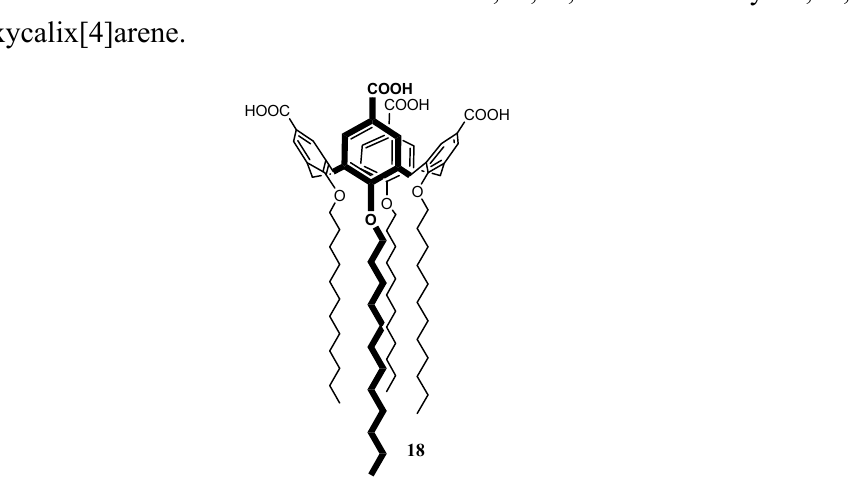
Figure 30. Chemical formula of 5,11,17,23-tetracarboxy-25,26,27,28- tetradodecyloxycalix[4]arene.